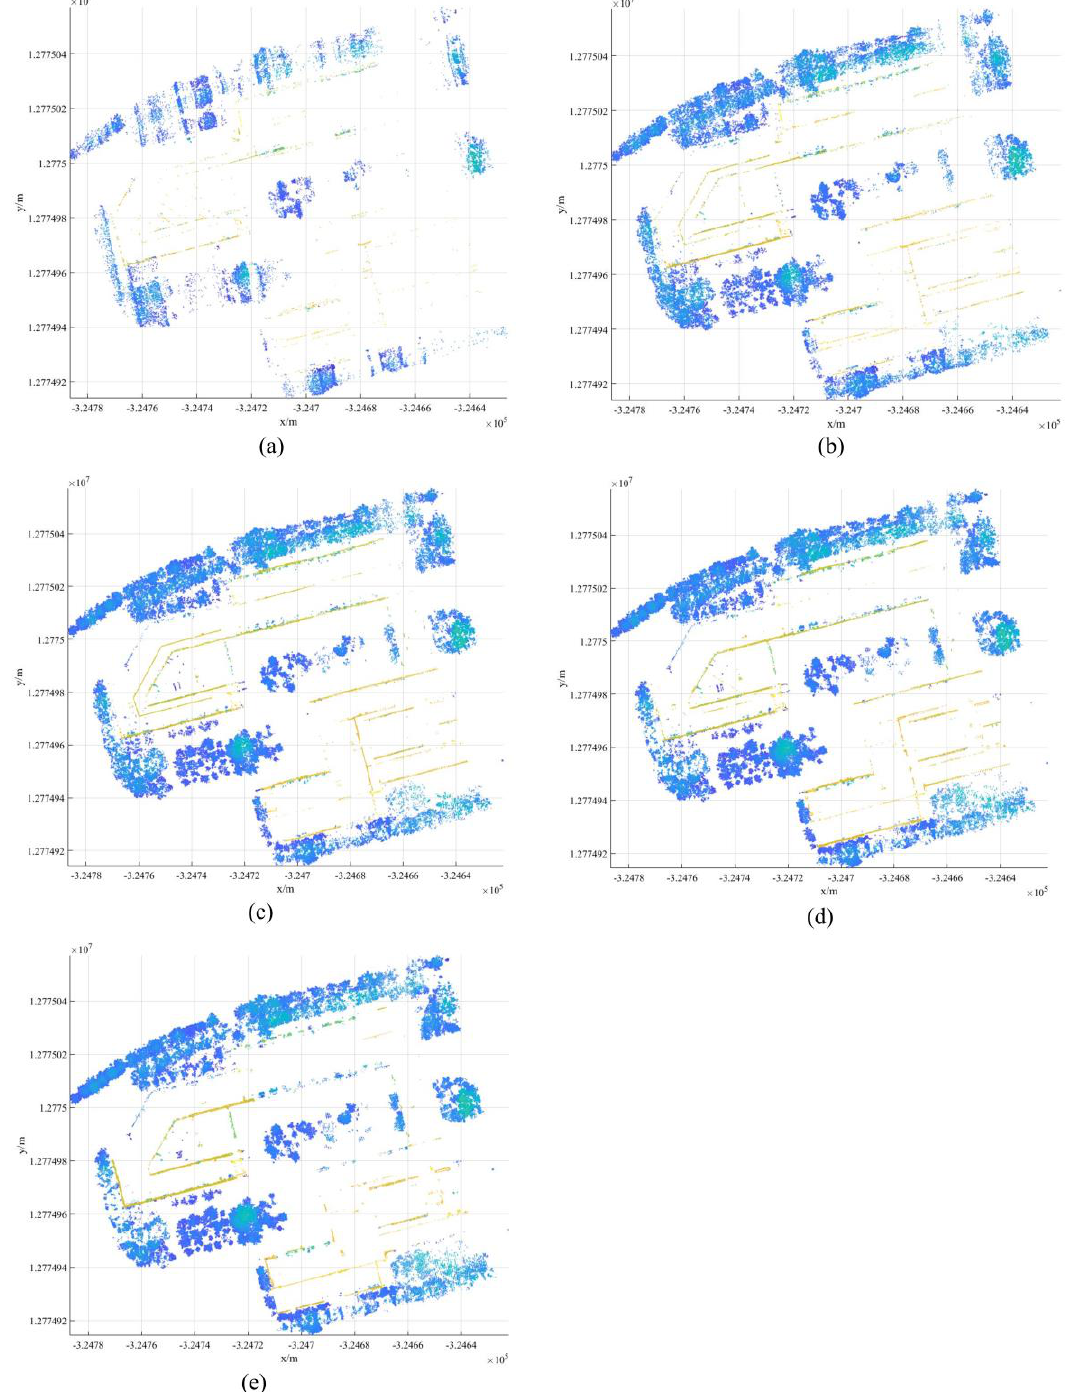
Figure 7. Vegetation extraction results at different R- neighborhood scales in plot 2. ( a ) R = 0.2 m; ( b ) R = 0.4 m; ( c ) R = 0.6 m; ( d ) R = 0.8 m; ( e ) R = 1 m.